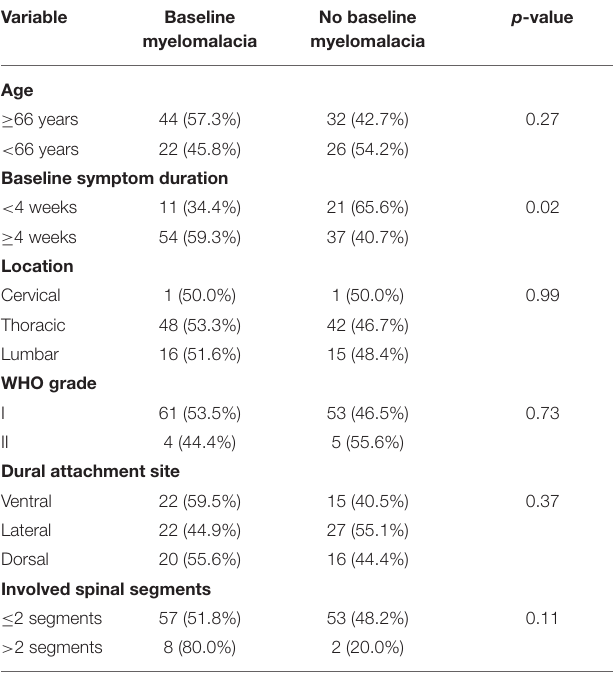
TABLE 3 | Association between baseline myelomalacia and clinical, imaging and histopathological features [Fisher’s exact test (two-sided)]. Variable